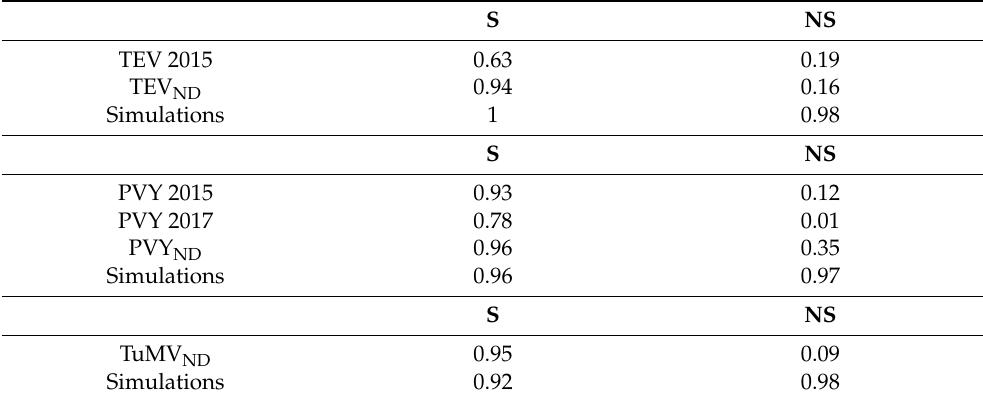
Table 1. Correlation coefficient (R 2 ) between coding sequence length of the TEV proteins and the mutations (S or NS). Experimental evolution: TEV 2015 [13], PVY 2015 [11], and PVY 2017 [12]. TEV ND , PVY ND , and TuMV ND; ND, natural diversity. Simulations: four in silico replicates.